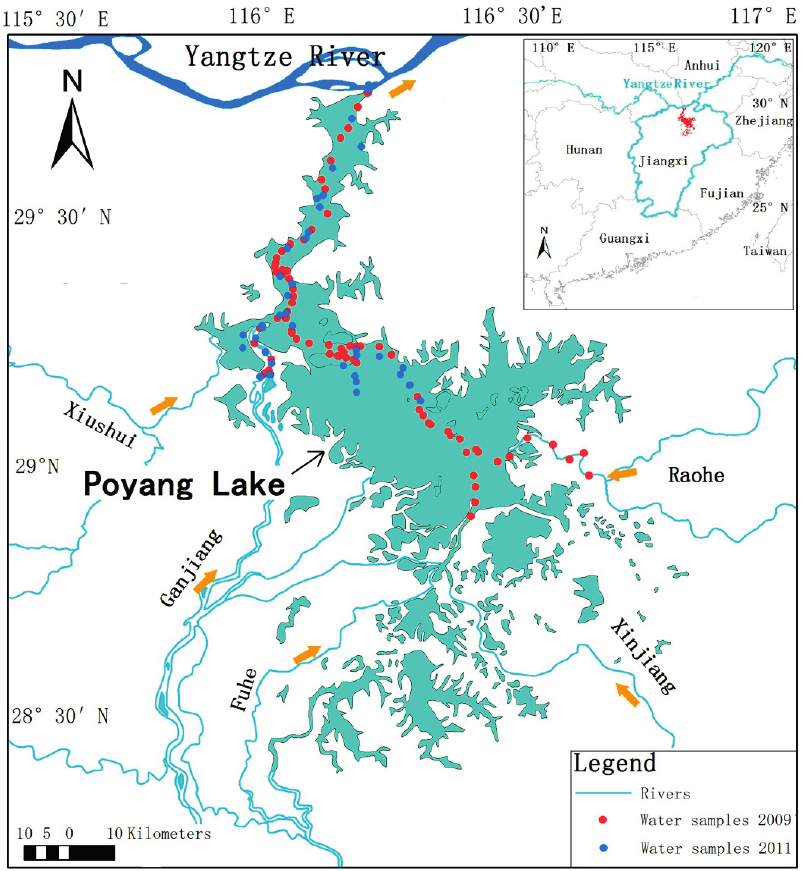
Figure 1. Location of Poyang Lake, the largest freshwater lake in China. The inset figure shows the lake’s drainage basin. Red and blue points represent the in situ stations during the two cruise surveys in 2009 and 2011, respectively, and orange arrows show the water flow